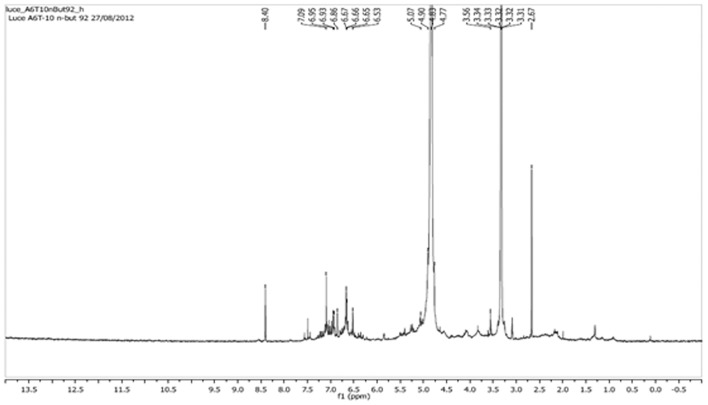
The nuclear magnetic resonance spectrum of hydrogen (1H) detected using a 300-MHz Varian instrument in CD3 OD. The chemical shift signals (δ or dpi) are shown for SF10-FBuOH.